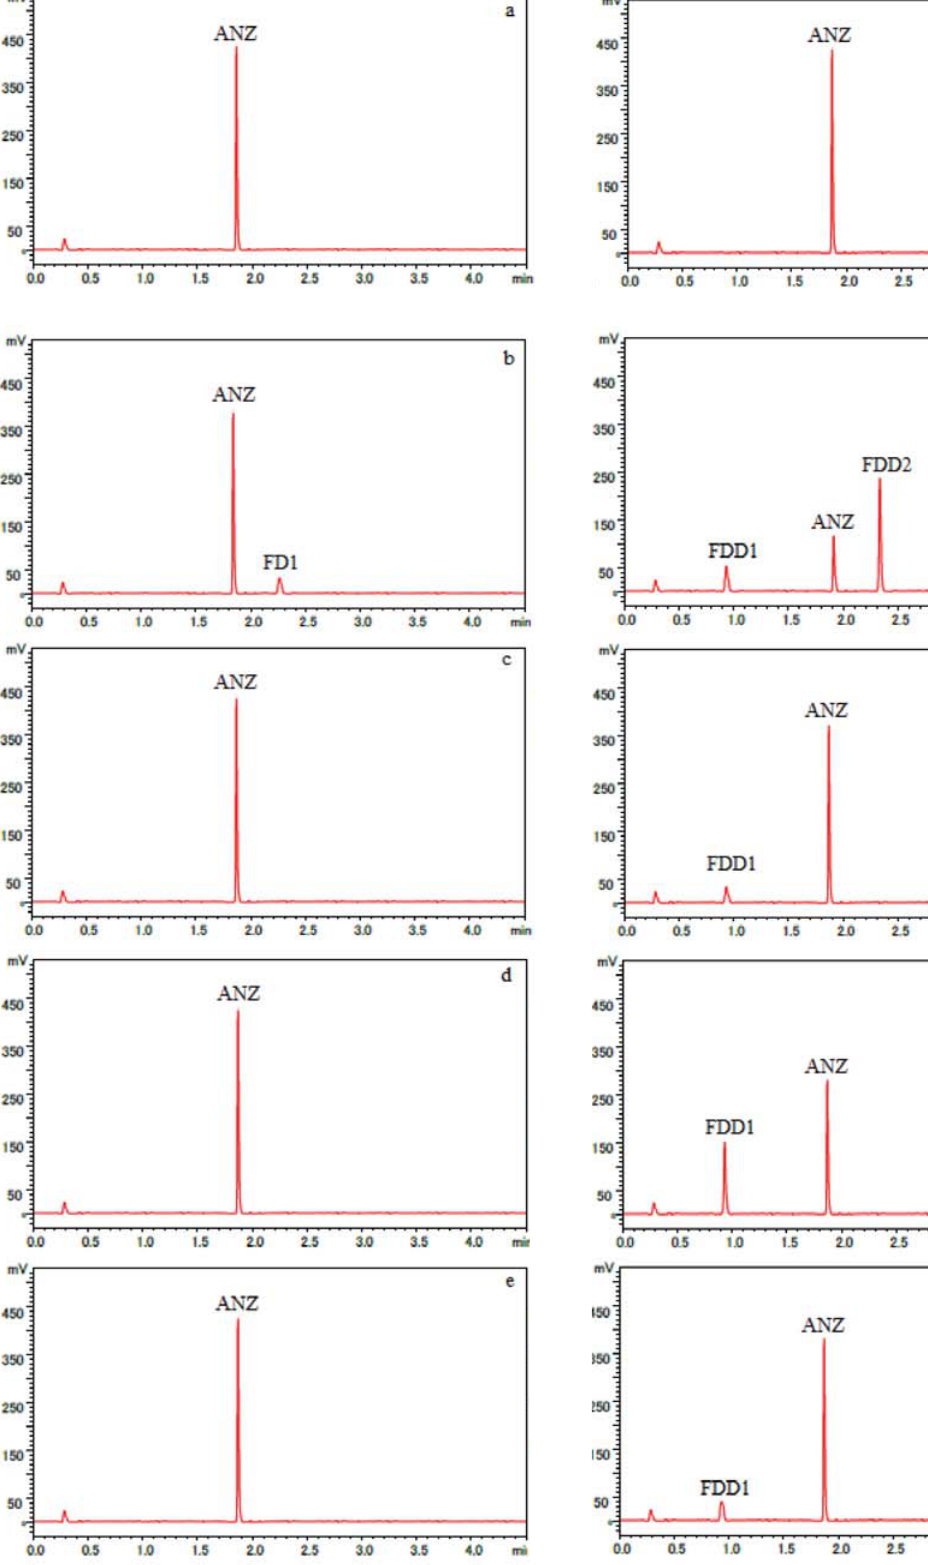
Figure 4. Typical UHPLC chromatograms of pure bulk sample of ANZ (50 μg mL –1 ) under stress conditions. Mild stress conditions: (a) acidic (b) basic (c) oxidative (d) thermal (e) photolytic. Drastic stress conditions: (f) acidic (g) basic (h) oxidative (i) thermal (j)